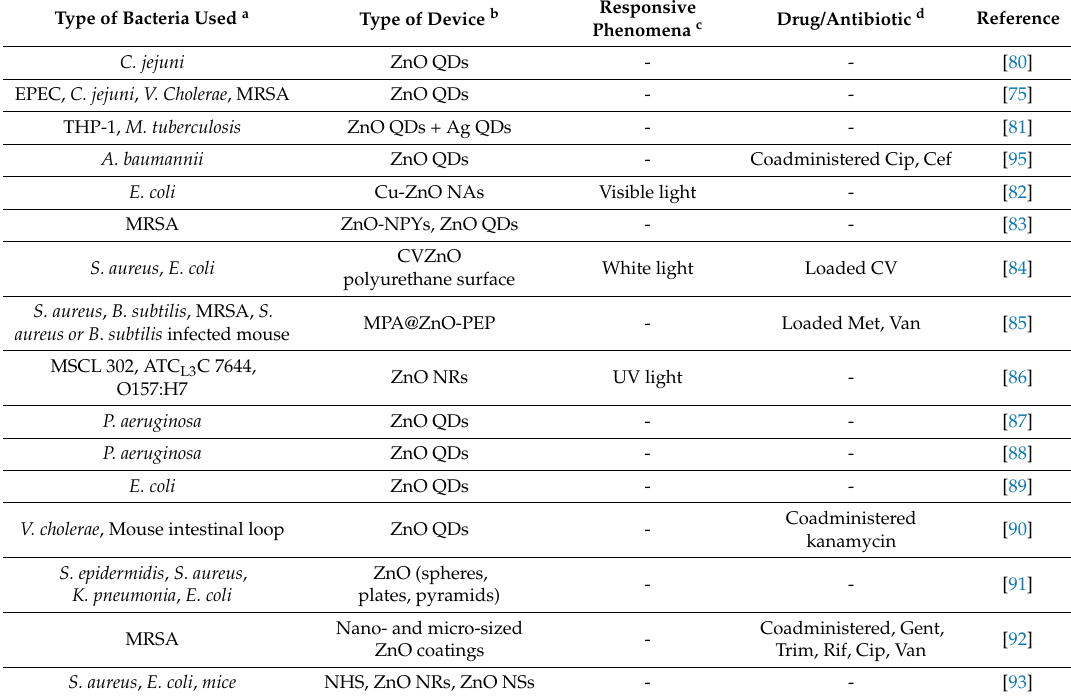
Table 2. ZnO nanoplatforms for theranostic bacterial